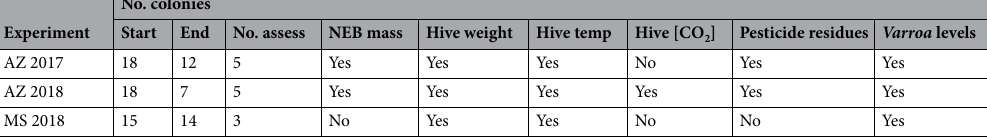
Table 1. Overview of experimental design, colony survivorship and response variables. NEB newly emerged bee. “Start” was defined as the beginning of the treatment period in mid-July; “End” was defined as February 12 of the following year; “No. assess.” means the number of colony